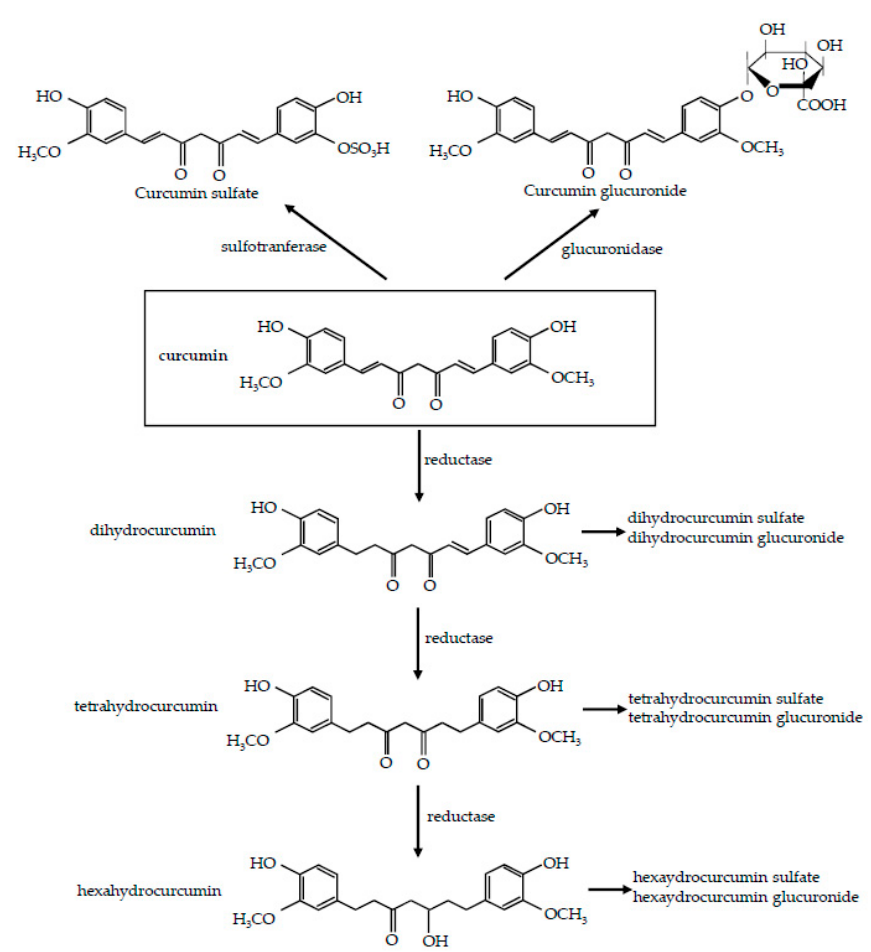
Figure 1. Metabolism of curcumin. Reduction pathway and the two main conjugation pathways, glucuronidation and sulfatation, are shown.